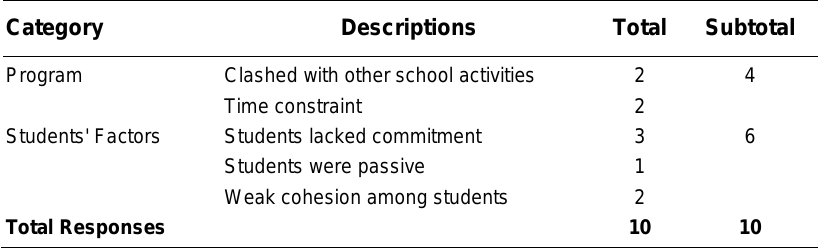
Responses on Encountered